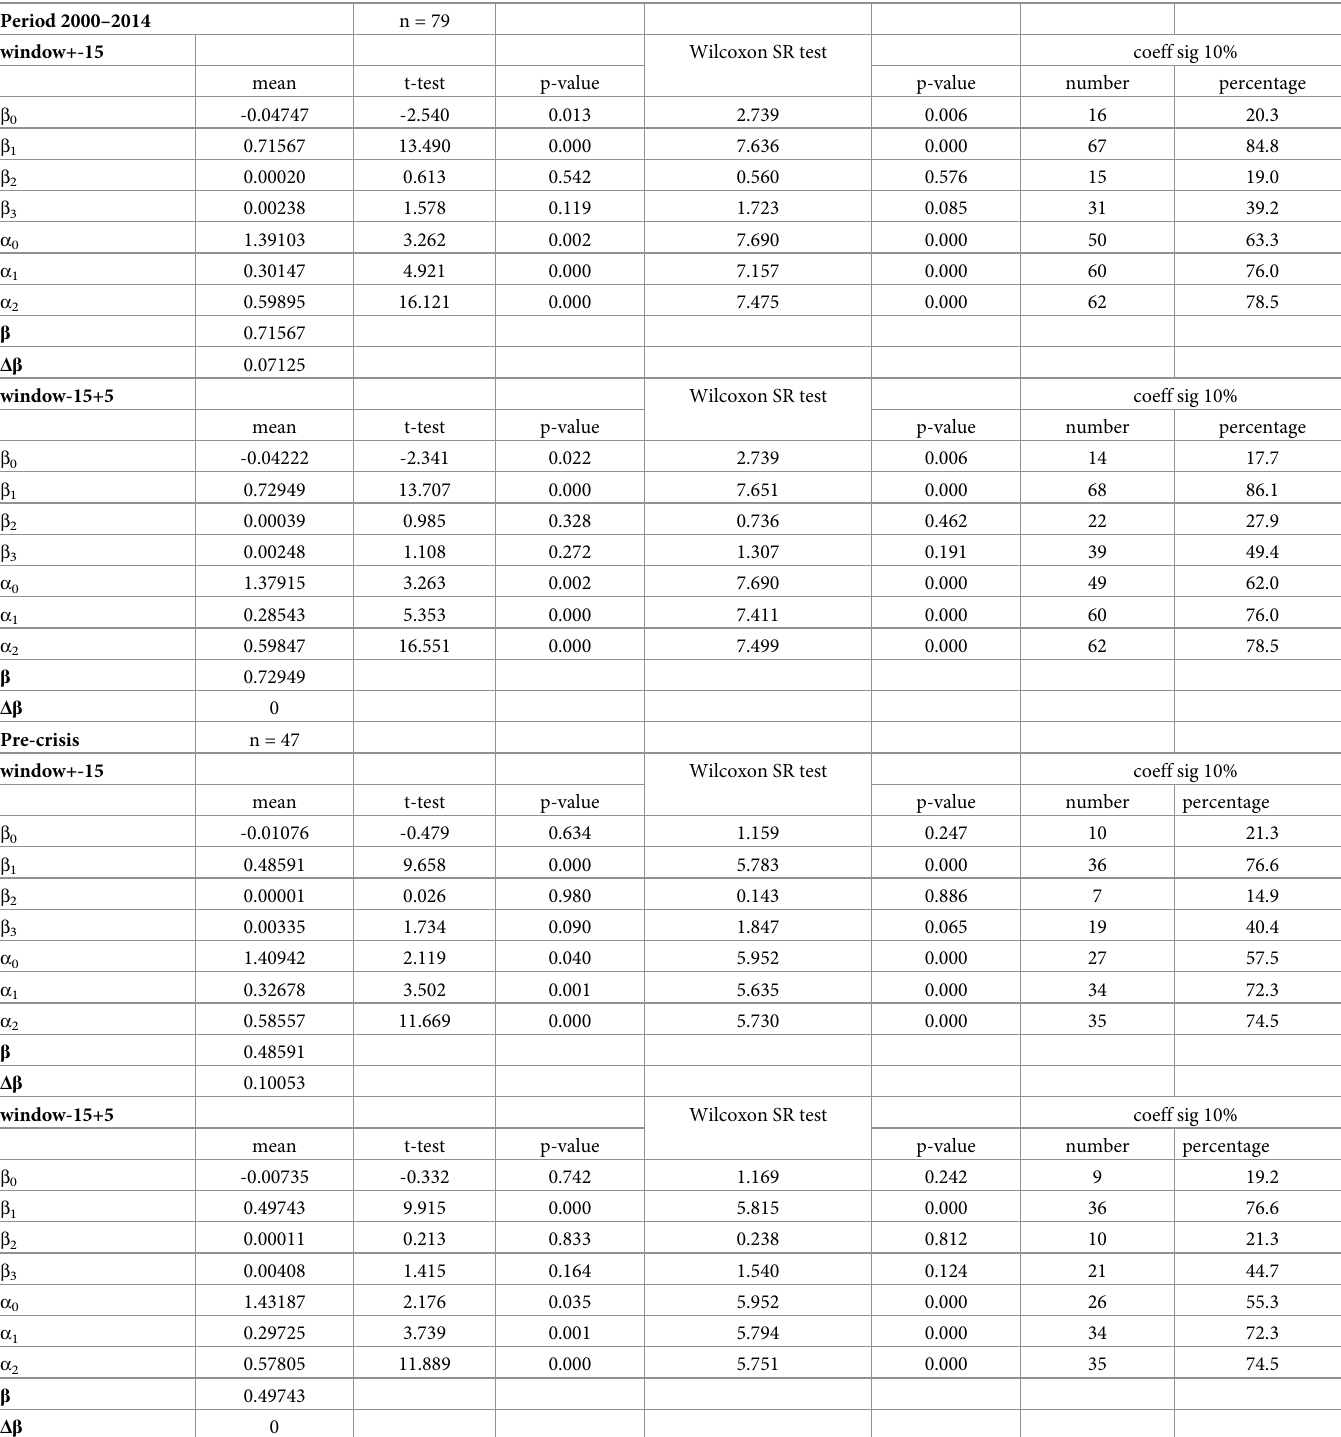
Table 13. Summary results: